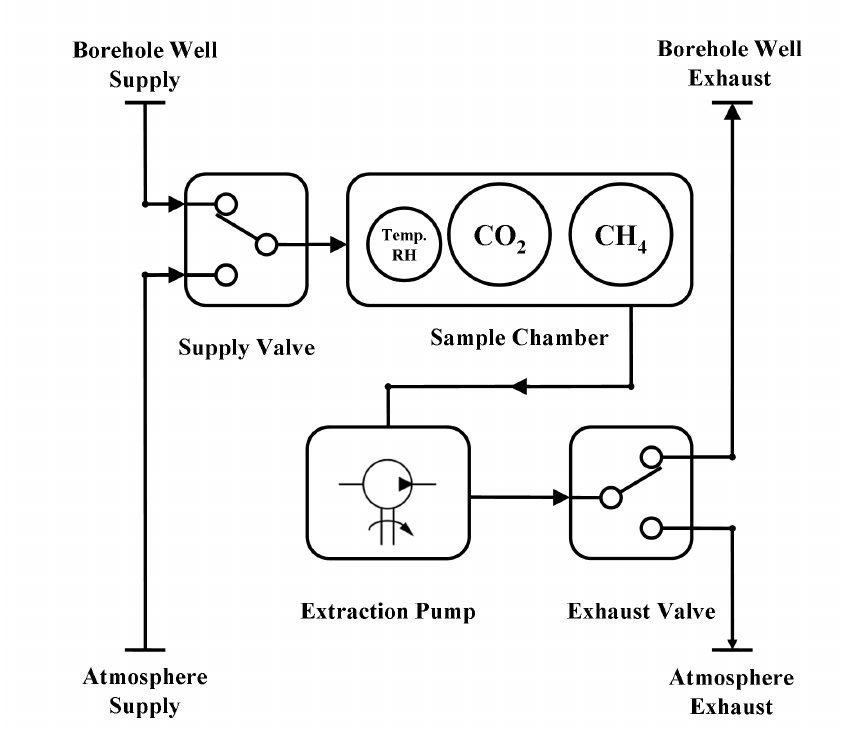
Figure 3. Schematic flow diagram illustrating the gas flow control system. The flow control valves allow the system to be switched between sampling mode (from ‘Borehole Well Supply Supply’ to the ‘Borehole Well Exhaust’) and baseline and purge modes (from ‘Atmosphere Supply’ to the ‘Atmosphere